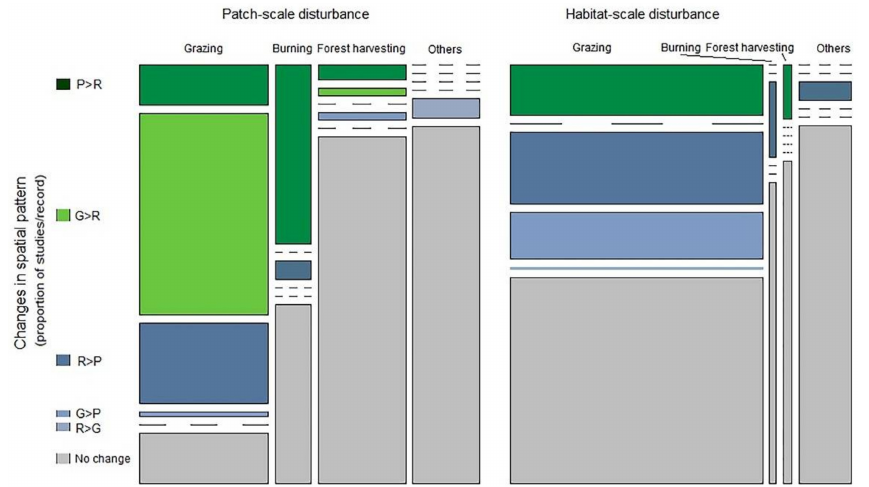
Figure A3. Mosaic plots of the relative frequency of disturbance-driven changes in the categories spatial patterns of biodiversity for different types and scales of disturbance. Bar widths are propor- tional to the number of studies. The height of each bar segment corresponds the relative frequency of certain type of pattern-change among studies for the disturbance type. P > R indicates a shift from patchy to random pattern, G > R indicates a shift from gradient to random, R > P indicates a shift from random to patchy, G > P indicates a shift from gradient to patchy, R > G indicates a shift from random to gradient